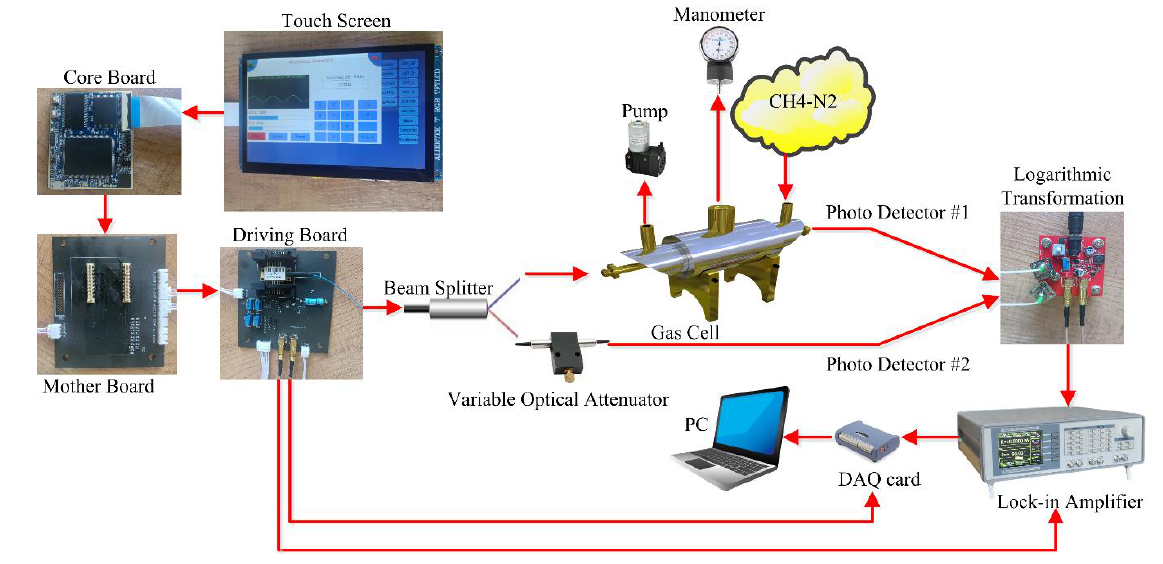
Figure 7. Schematic diagram of the experimental setup.